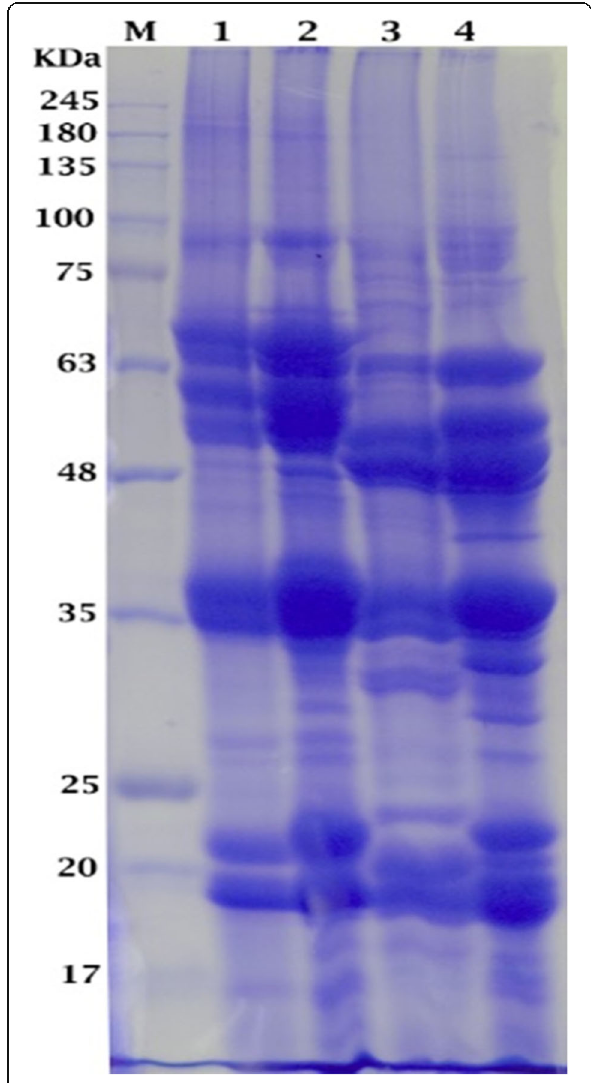
Fig. 2 Electrophoretic patterns of the total seed storage protiens in four Vicia species. 1, Vicia angustifolia L. ssp. Angustifolia. 2, Vicia cordata wulfen ex Hoppe. 3, Vicia dalmatica A. Kern. 4, Vicia johannis